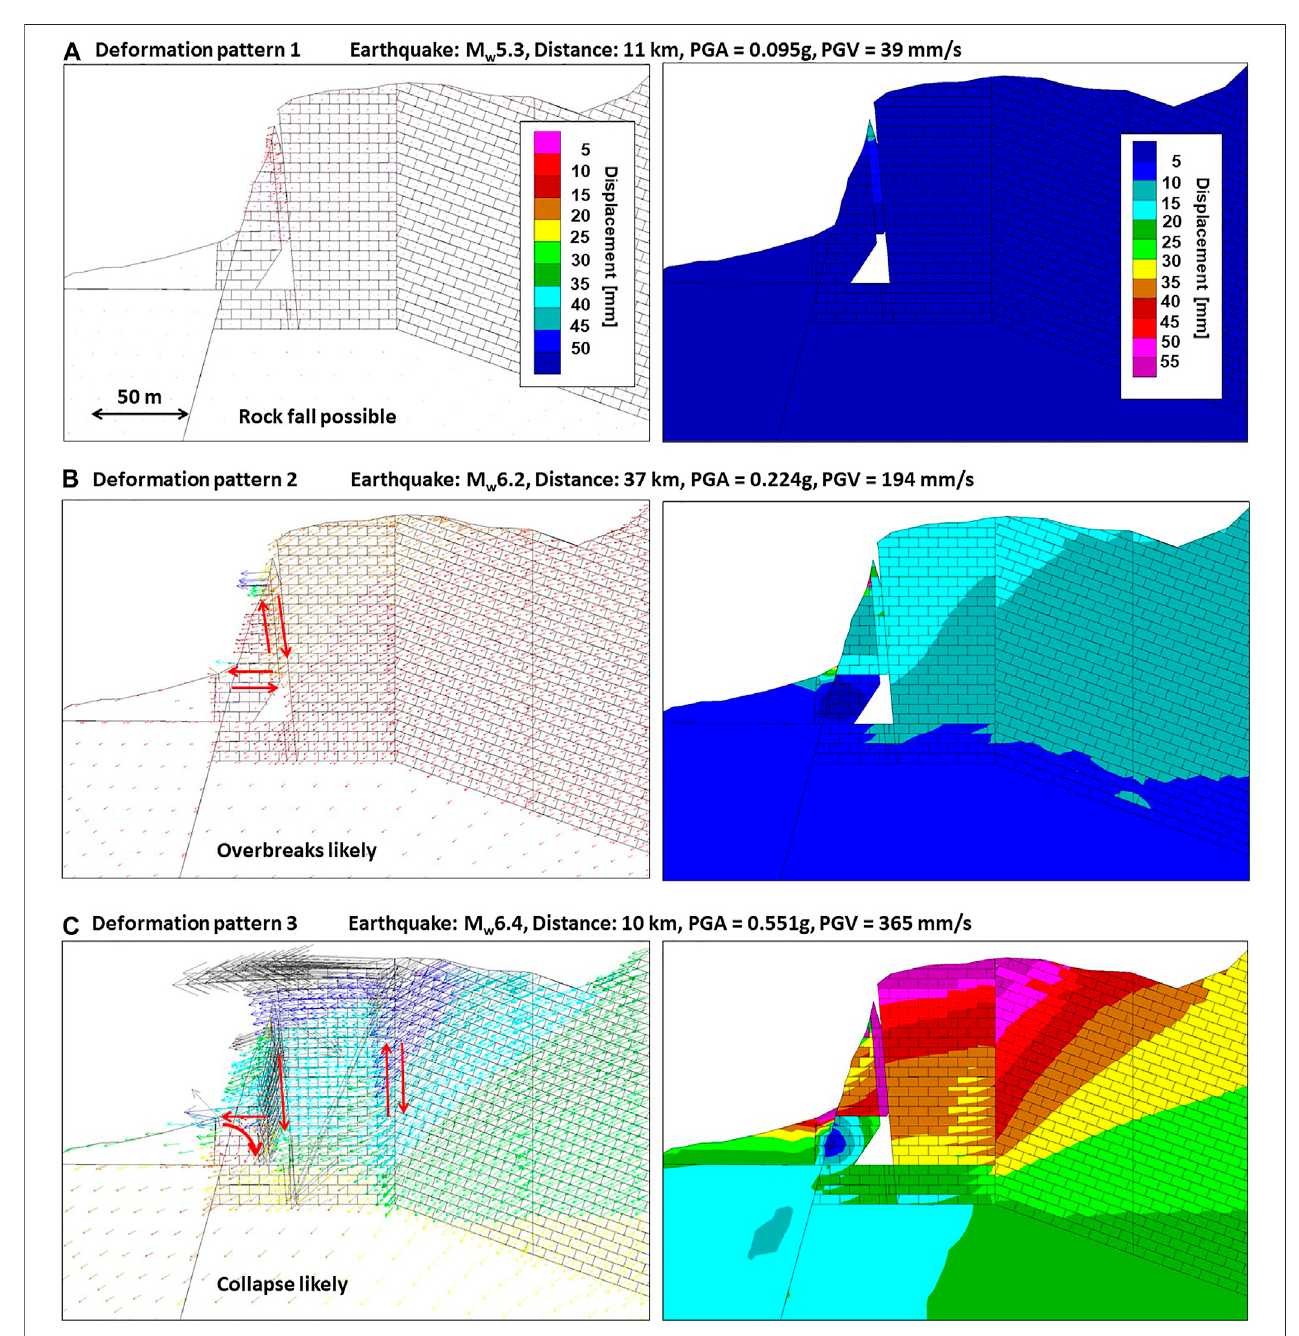
FIGURE 8 | Typical deformation patterns with (A) falling blocks, (B) a partial collapse of the train tunnel and (C) downbursts from the Mitholz-fault with a partial emptying of the back fi ll modelled in UDEC with different earthquake scenarios described in the subtitles. The legend of (A) is valid for all patterns.